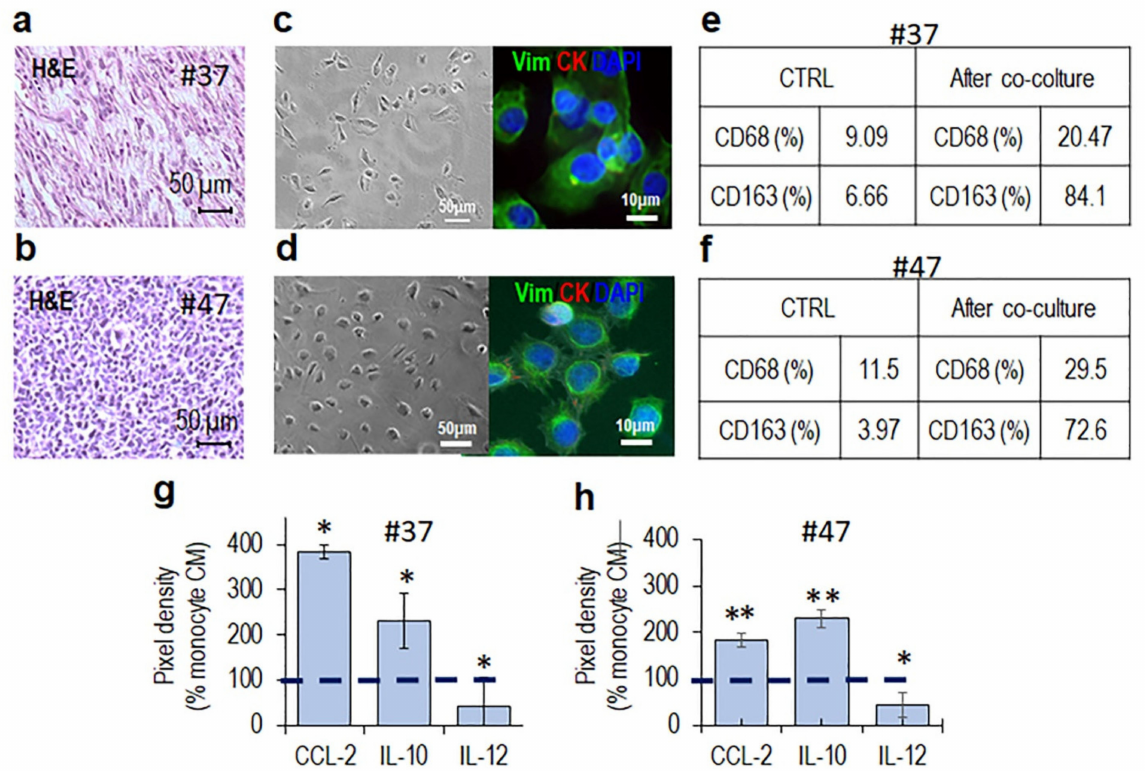
Figure 5. MLPS cells trigger M2-like polarization of monocytes in non-contact co-cultures. ( a , b ) Representative images of H&E staining of FFPE sections from #37 ( a ) and #47 ( b ) MLPS tissues acquired at 200 × magnification. ( c , d ) Primary MLPS cells obtained by enzymatic digestion of 37 ( c ) and #47 ( d ) tumor tissues, visualized by phase contrast microscopy (left) and fluorescent microscopy after immunostaining with anti-vimentin and anti-cytokeratin Abs (right). Nuclei were stained blue with DAPI. Original magnifications: 200 × (left) and 400 × (right). ( e , f ) Human monocytes were co-cultured with #37 ( e ) and #47 ( f ) primary MLPS cells in an in vitro non-contact co-culture for 72 h and then analyzed for CD68 and CD163 expression by flow cytometry. ( e , f ) Percent variation of CD68 and CD163 on monocytes collected after non-contact co-culture, compared to control monocytes. ( g , h ) After co-cultures with #37 ( g ) and #47 ( h ) primary MLPS cells, CMs from monocytes were analyzed for the content of CC2, IL-10, and IL-12 by a dot plot assay. The pixel density of each spot was measured using NIH Image J 2.0 software developed by the US NIH, USA and positive control spots were used to normalize results between the membranes. The intensity of each spot was averaged over the duplicate spots and expressed as percentage of each cytokine or chemokine spontaneously secreted by control monocytes (monocyte CM), considered as 100% (dashed line). Data represent mean ± SD from three experiments performed in duplicate with * p < 0.05, ** p <